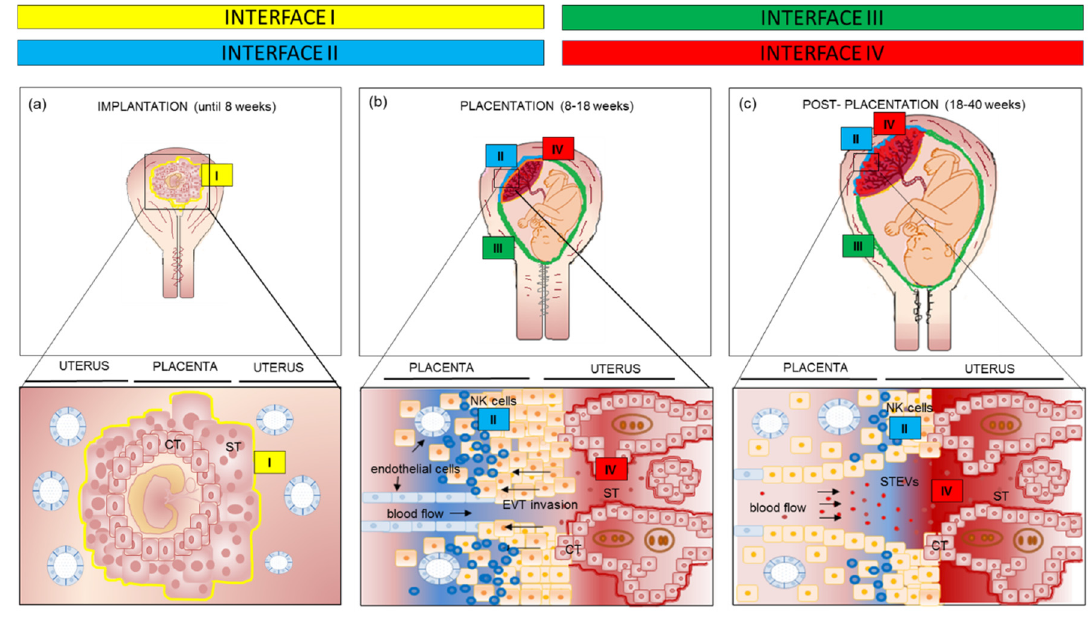
Figure 1. Main immunological interfaces between fetus and mother according to different gestational ages, from implantation to placentation process and post-placentation period. ( a ) Until 8 weeks of gestation the interface I is represented by ST invading the decidua; ( b ) in the second trimester of pregnancy the interface I is replaced by the interface II (decidual natural killer cells—extravillous trophoblast), III (decidua parietalis—amniochorion) and IV (maternal blood—ST); ( c ) in the third trimester interface IV is the dominant one. CT: cytotrophoblast; ST: syncytiotrophoblast; EVT: extravillous trophoblast.